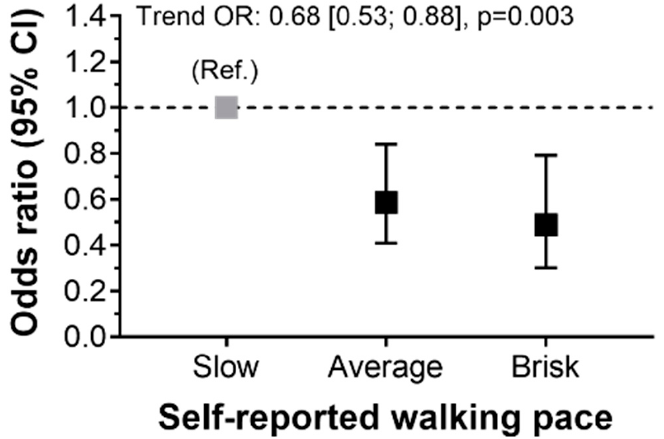
Figure 2. Association between walking pace and T2D. Data presented as odds ratio (OR) and its 95% confidence interval. Slow walking pace was considered as a reference value (Ref). Results were adjusted for model 3—age, sex, educational level and residence setting (urban/rural), BMI, smoking, alcohol, sleep duration, fruit and vegetable intake, and sitting time.